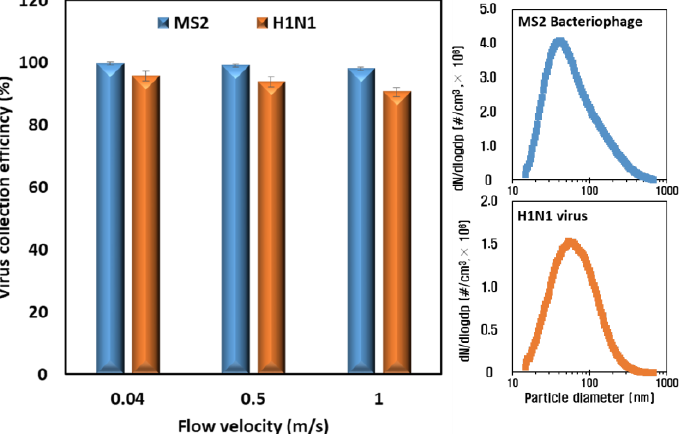
Figure 7. Collection efficiencies of airborne virus particles when increasing the face velocities (left) and size distributions of airborne virus particles (right). and size distributions of airborne virus particles ( right